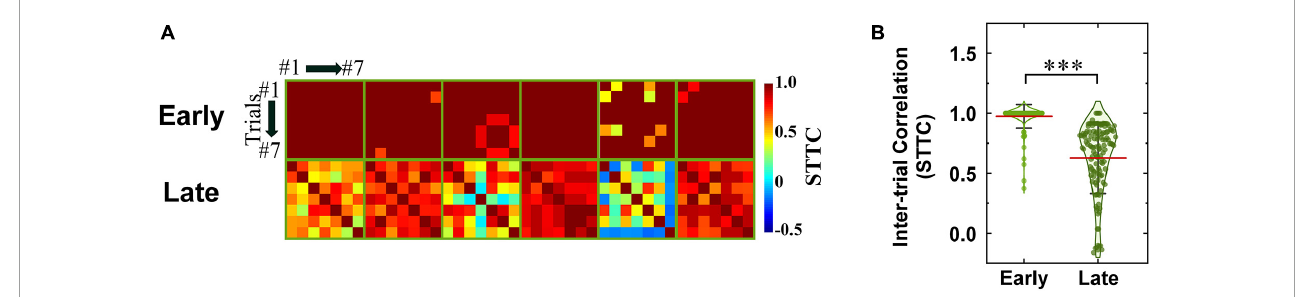
FIGURE8 Spike timing consistencies of DS RGCs in rd8 retinas are comparable to those of DS RGCs in wt retinas. (A) Color-coded heatmaps of the spike time tiling coefficients (STTCs) of early and late responses in the rd8 DS RGCs. An identical stimulus repeated typically for seven times (at least six times). Black color in matrices indicates no response was elicited in those trials. (B) Violin plots of all STTCs computed from rd8 RGCs. Red horizontal line indicates average STTC value of each group. Statistical significance test was performed using the one-way ANOVA with Holm–Sidak post-hoc comparisons; ∗∗∗ p < 0.001. Statistical significance comparisons between rd8 and wt RGCs are shown in Table 2